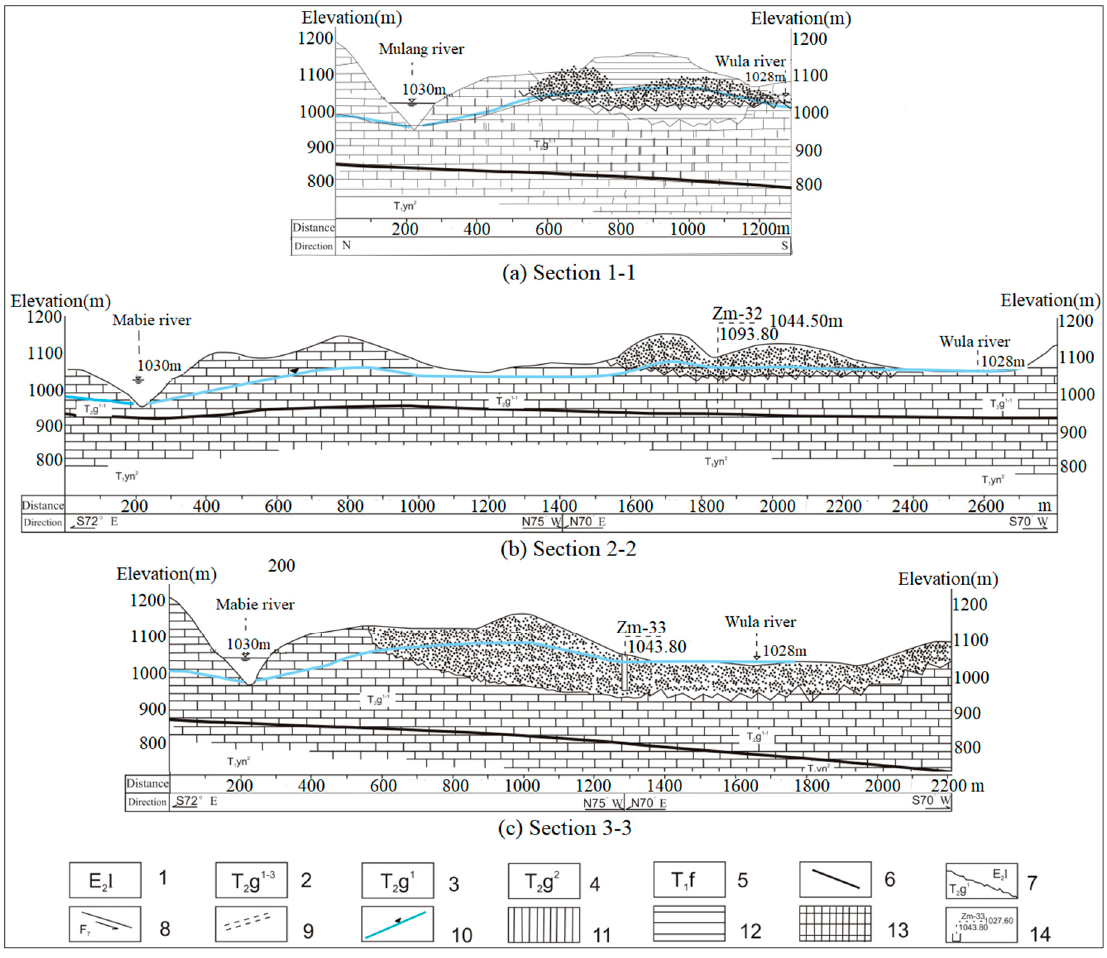
Figure 5. Karst hydrogeological sections of reservoir area.1. Tertiary, fuchsia siltstone, breccia, 2. The lower part of the limestone and dolomite in the lower part of the Guanling Formation, 3. The thin layer to medium thick layer of limestone in the lower part of Yongning Town Group, 4. Thick layer to medium-thick layer limestone in the lower part of Yongning Town, 5. Feixianguan Formation siltstone and mud shale, 6. Composite formation boundaries, 7. Unconsolidated stratigraphic boundaries, 8. Faults and numbers, 9. Speculated karst pipeline, 10. Groundwater level line, 11. A fractured aquifer, 12. Karst aquifer, 13. Relative to the water barrier, 14. Drill number (upper number), elevation (lower number) and water level (number on the right).